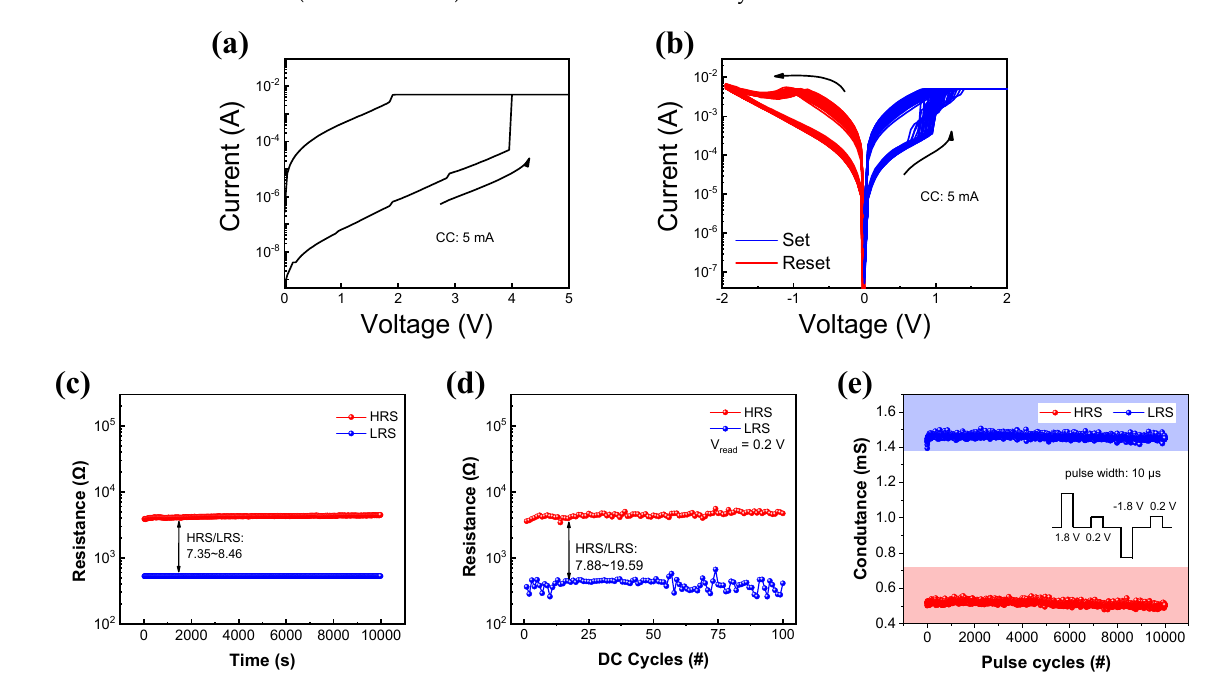
Figure 2. I-V curves of ( a ) forming process and ( b ) bipolar resistive switching including set and reset processes. ( c ) Retention and ( d ) endurance test by DC sweep. ( e ) Endurance test by pulse mode.